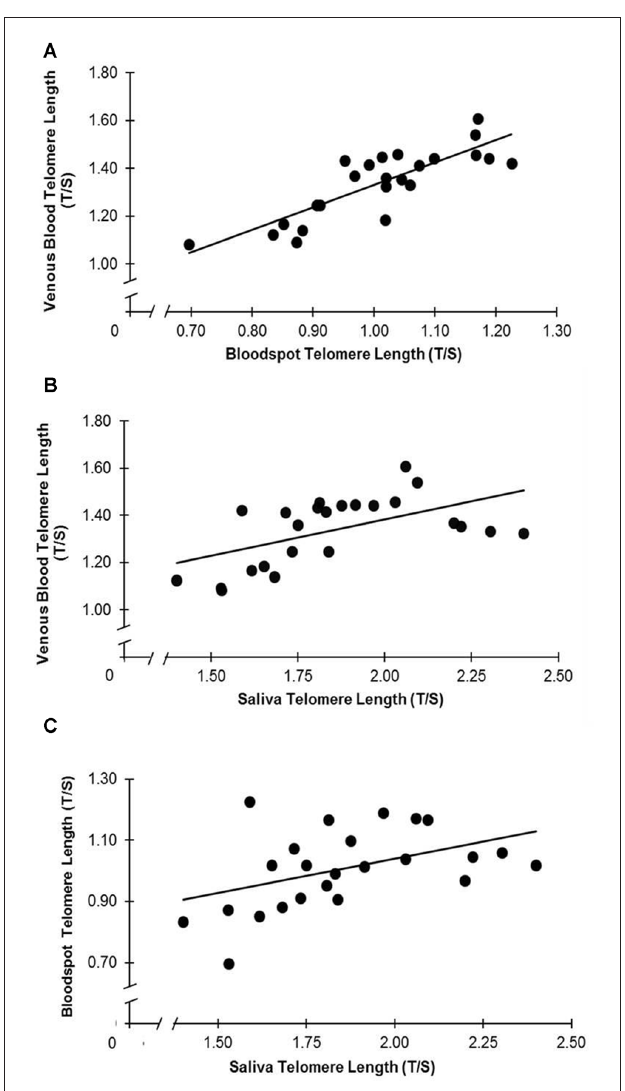
FIGURE 1 | (A–C) Telomere length (TL) is associated across collection types. (A) T/S in venous blood and dried blood spots (DBS) are correlated ( r = 0.84, p < 0.001). (B) T/S in saliva and venous blood are correlated ( r = 0.56, p = 0.005). (C) T/S in saliva and DBS are correlated ( r = 0.45, p = 0.027).